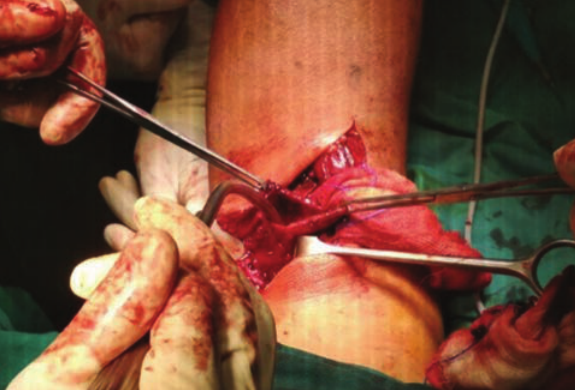
The aneurysmal wall held by Allis forceps on each side. Fig. 3: The sac is in direct continuation to the popliteal